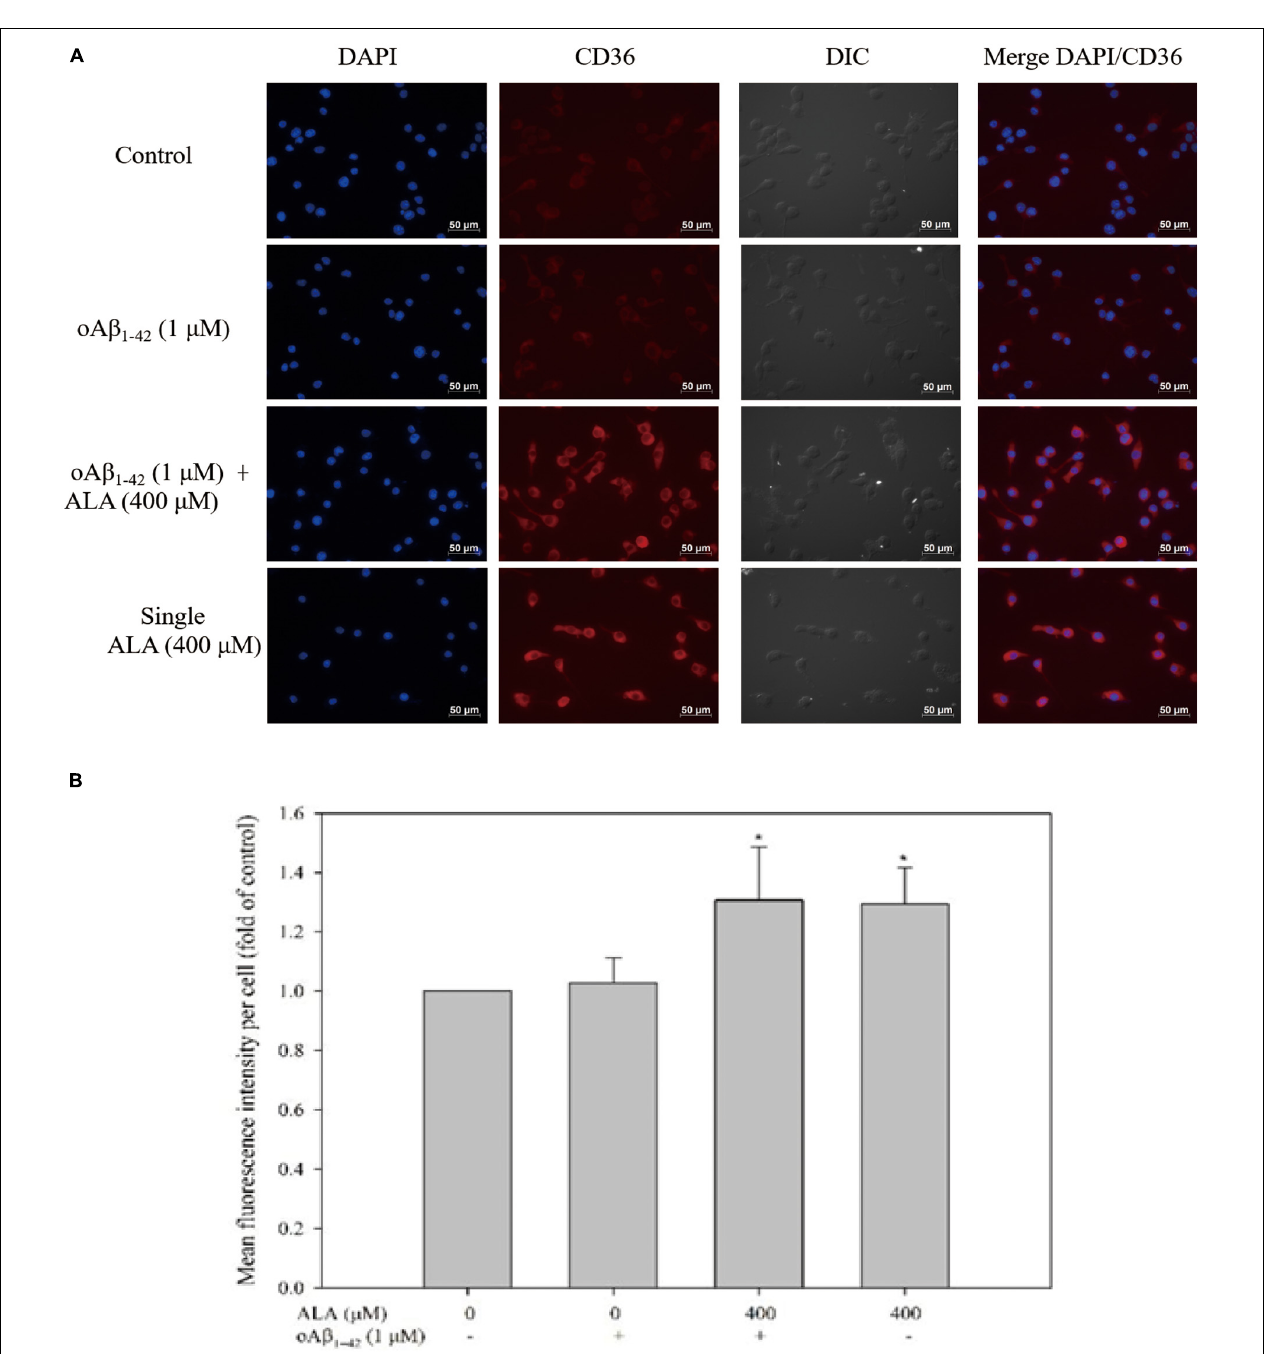
FIGURE 5 | Alpha-lipoic acid elevated CD36 protein expression in BV-2 mouse microglial cells. BV-2 cells were pretreated with or without ALA (400 µ M) for 30 min, followed by vehicle or oA β 1 − 42 treatment for 24 h. After treatment, BV-2 cells were immunostained with CD36 antibody (red) and the nuclei were stained with DAPI (blue). (A) Fluorescence image from immunocytochemistry. (B) Quantification of mean fluorescence intensity per cell. * p < 0.05 vs. the control